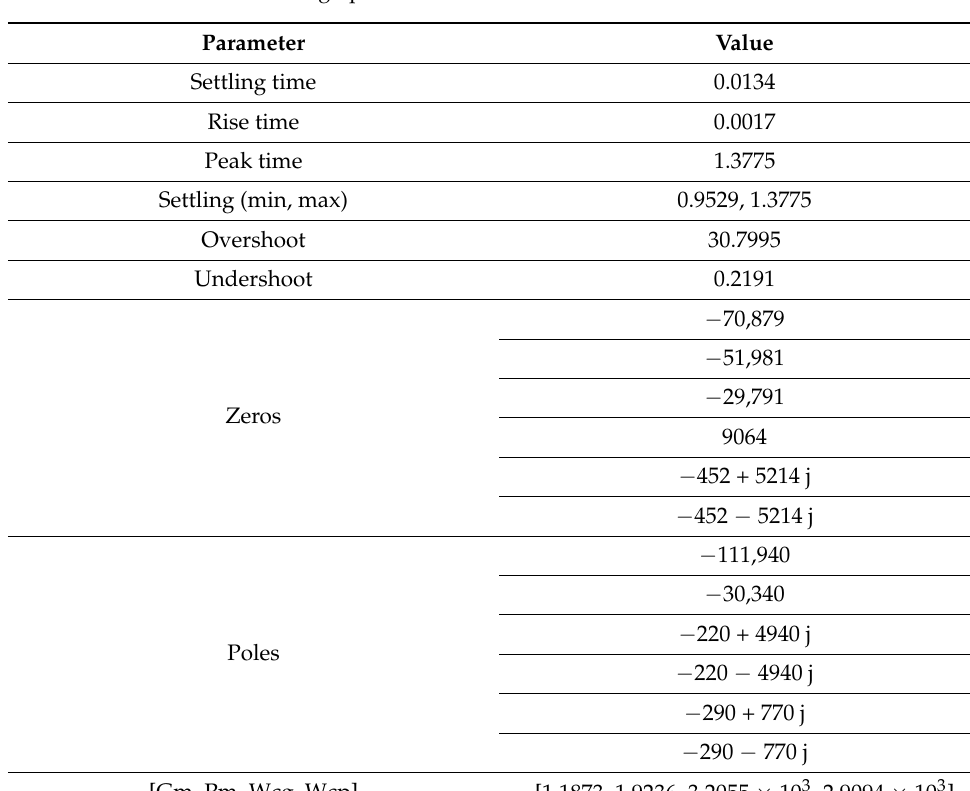
Figure 7. The step response for Equation (31). Table 5. SCZEB Converter Design